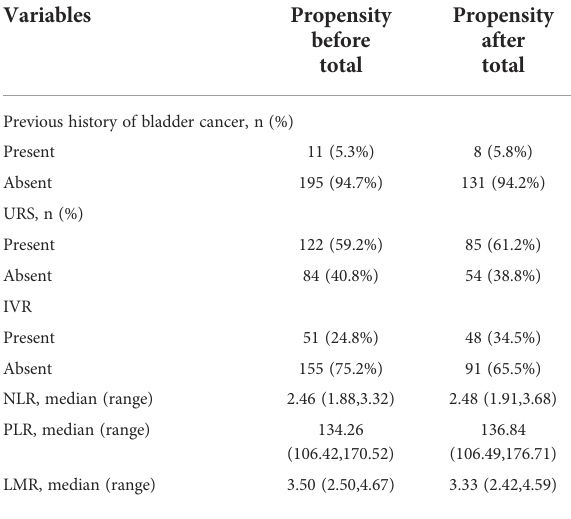
TABLE 2 Demographic and clinicopathological characteristics of 139 patients after propensity score